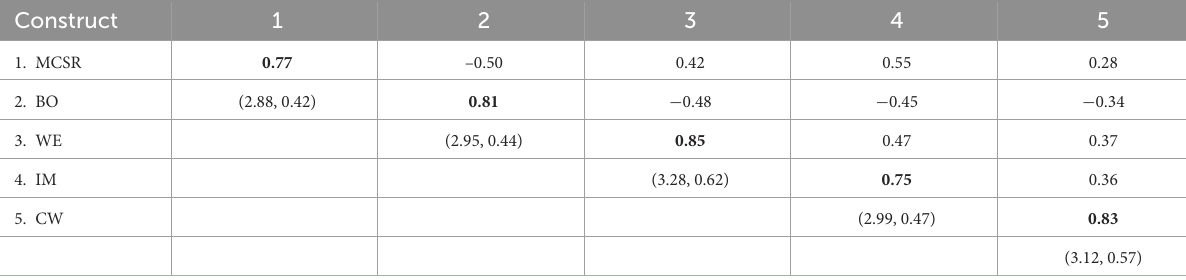
TABLE 5 Correlations and discriminant validity.